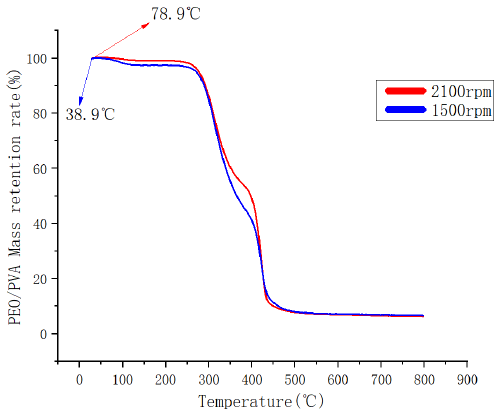
Figure 12. TG curves of PEO/PVA composite nanofibers.